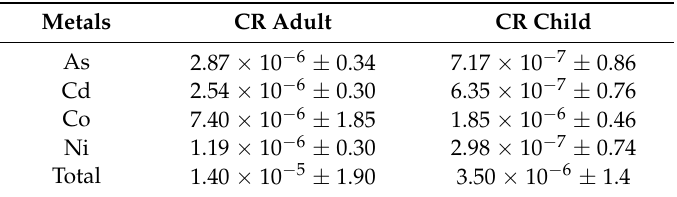
Table 7. Carcinogenic risks (CR) via inhalation exposure for adult and child.